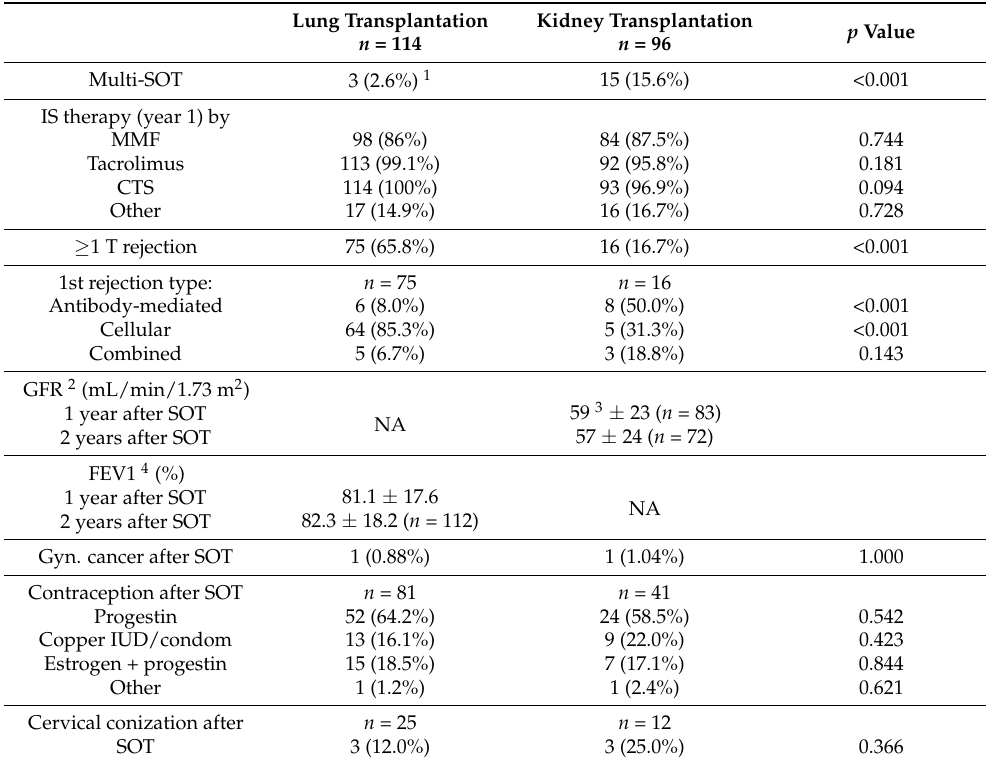
Table 2. Clinical profiles of patients at and after